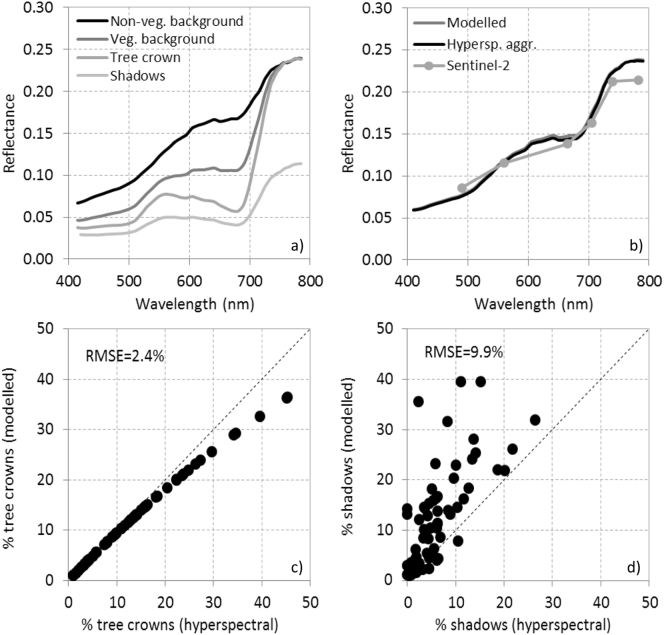
Canopy reflectance simulation conducted using the scene components extracted from the hyperspectral image for one of the validation sites (a) comparing against aggregated hyperspectral and Sentinel-2A imagery (b). The modelled crown percentage cover and the shadow component for all validation sites are shown in (c) and (d), respectively.